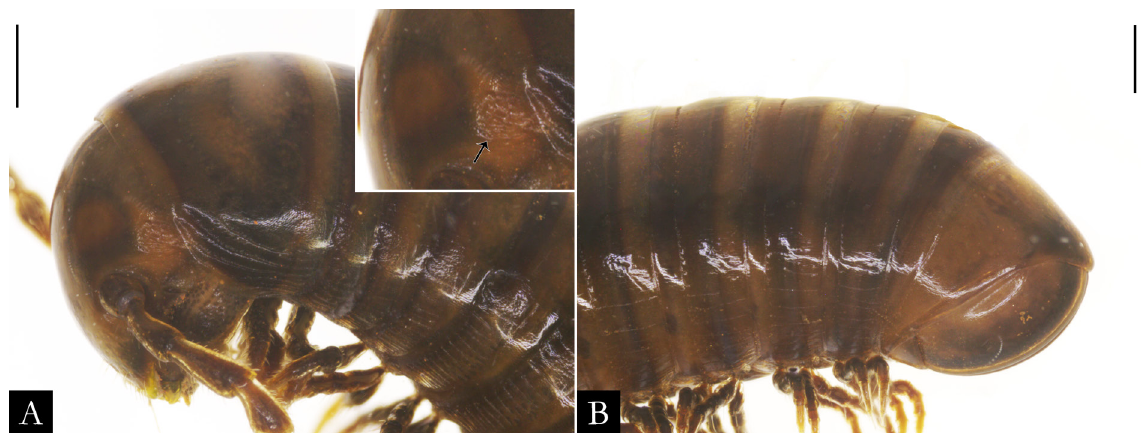
Fig. 127. Pseudonannolene spelaea Iniesta & Ferreira, 2013, ♂ (IBSP 5923), in lateral view. A . Anterior region (arrows indicating the ommatidial cluster). B . Posterior region. Scale bars = 0.5